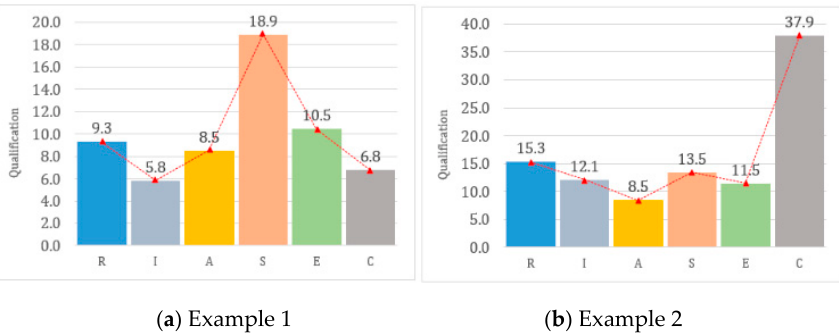
Figure 19. Graphical representation of the results obtained for vocational profile evaluation: Examples 1 and 2.